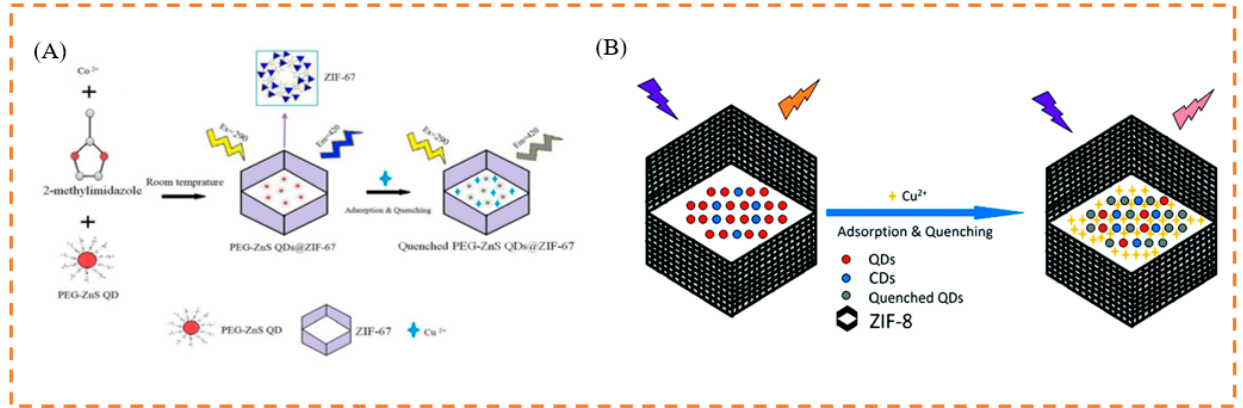
Figure 7. ( A ) Schematic illustration of the process for sensing Cu 2+ based on fluorescent PEG-ZnS nanohybrids. ( B ) Schematic illustration of the process for sensing Cu 2+ based on fluorescent QDs/CDs@ZIF-8 composite. Reproduced with permission from [77,78]. Copyright 2019, Elsevier; and 2017, Royal Society of Chemistry.